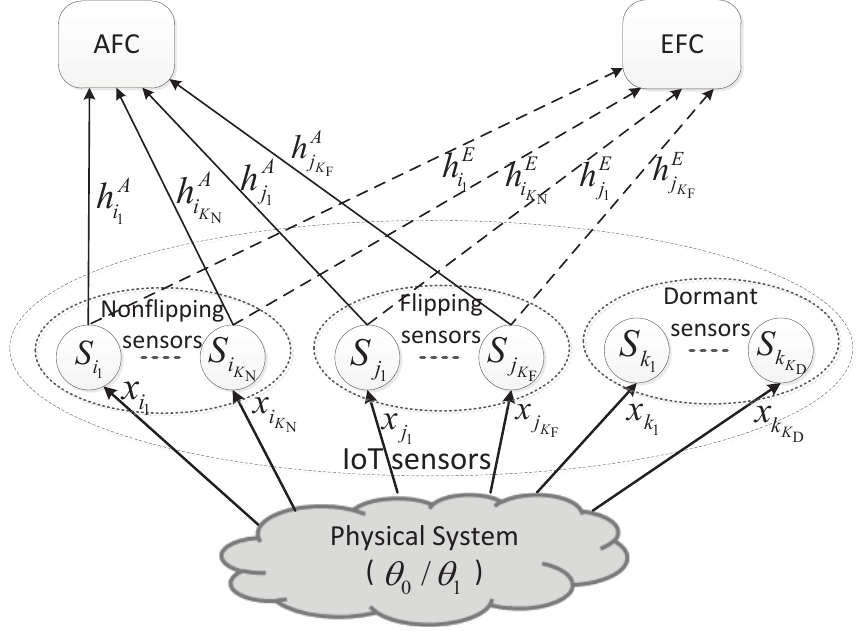
Figure 1. IoT sensor network with the ally fusion center and eavesdropping fusion